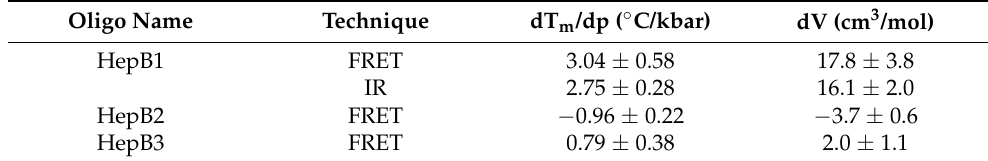
Figure 5. Transition temperatures of HepB1 versus pressure determined by FTIR spectroscopy. Table 3. Pressure dependence of unfolding temperature and the calculated volume-change values for the HepB oligos in the presence of potassium